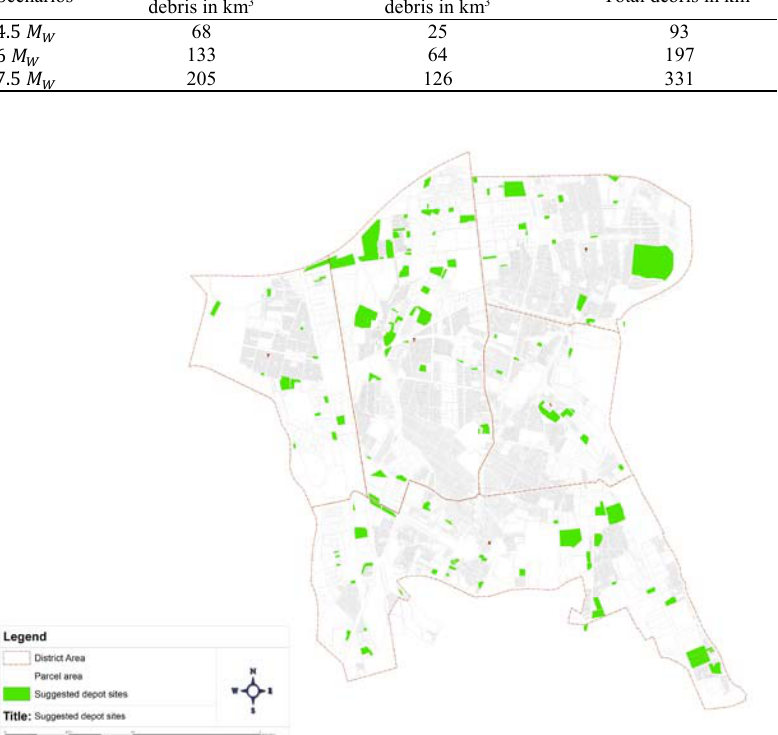
Fig. 1: Distribution of depot locations for the debris in Ray City